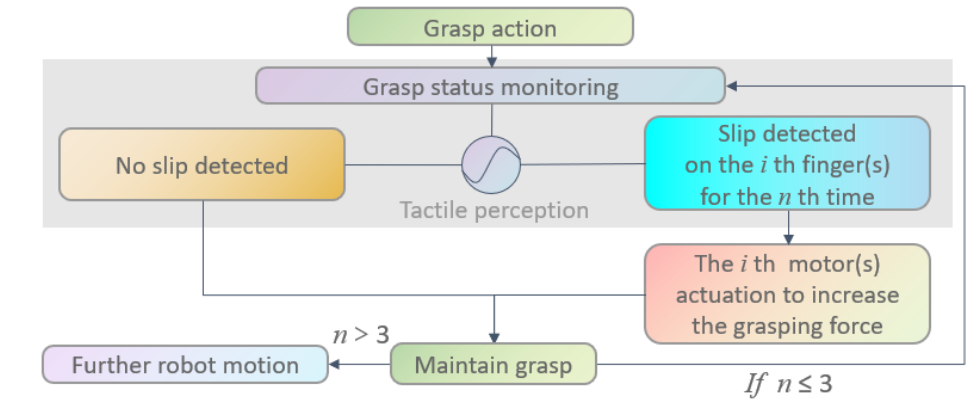
Figure 4. Control flow diagram of the proposed closed-loop grasp